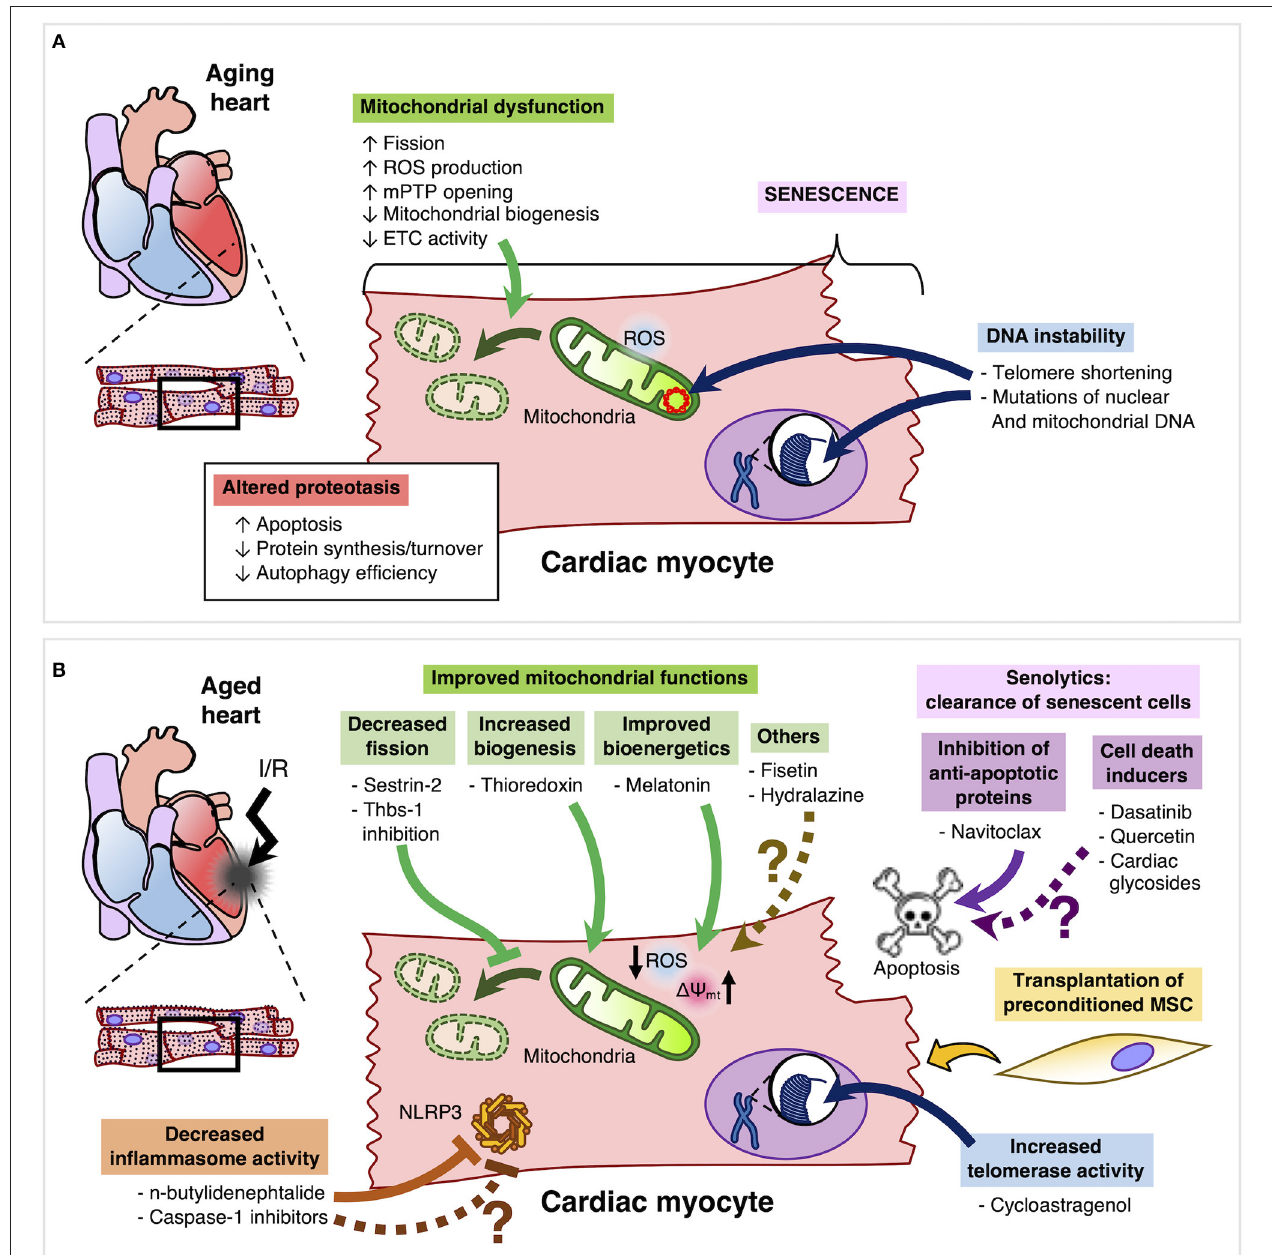
FIGURE 1 | (A) Aging cardiomyocytes are mainly characterized by mitochondrial dysfunction, senescence, altered proteostasis and DNA instability. (B) Improvement of mitochondrial dysfunction in aged cardiomyocytes may be achieved by inhibition of Thbs-1 and Sestrin-2, which can decrease Drp-1-mediated mitochondrial fission. Moreover, thioredoxin can promote mitochondrial biogenesis and melatonin can improve bioenergetics by reducing ROS production and improving mitochondrial membrane potential. Other compounds such as Fisetin and hydralazine can confer cardioprotection by reducing mitochondrial dysfunction, but whether these compounds can effectively limit the infarct size and improve left ventricular function of the aging heart remains to be elucidated. Senolytics can clear senescent cells by inhibiting anti-apoptotic proteins. However, only Navitoclax has been tested in the aged heart. However, other senolytics such as Dasatinib, Quercetin, and cardiac glycosides are yet to be evaluated in the settings of cardioprotection and aging. Furthermore, activation of telomerase in order to preserve telomere length and integrity is a promising candidate for cardioprotection in the aging heart. Another emergent target is to inhibit the inflammasome by compounds such as n-butylidenephtalide. Finally, the transplantation of preconditioned mesenchymal cells may have an important therapeutic role in the protection of the aged myocardium.